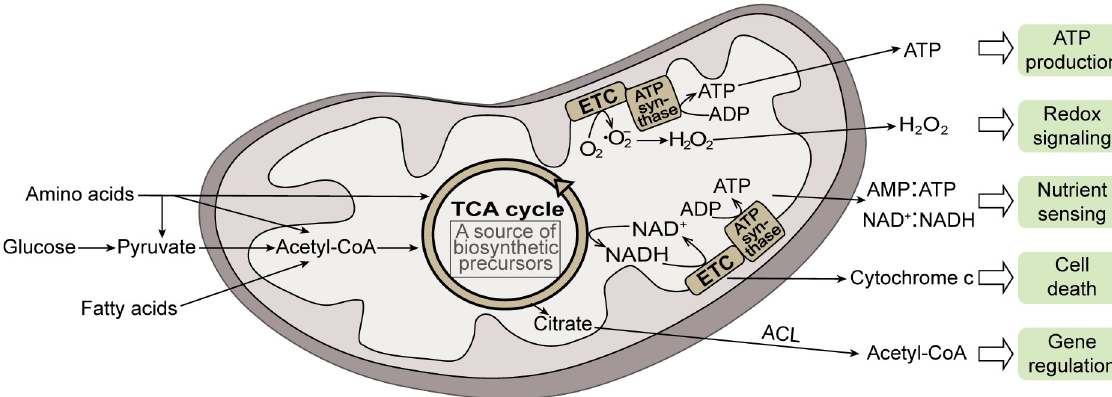
Fig 1. The mitochondrion is a multifunctional organelle. During mitochondrial bioenergetics, acetyl-CoA converted from food molecules is oxidized to produce ATP. In addition to ATP production, mitochondria play essential roles in cell signaling including nutrient sensing, redox signaling, cell death, and many other functions [3, 7]. Note that biosynthetic pathways in mitochondria [4] are omitted in the diagram. ADP, adenosine diphosphate; AMP, adenosine monophosphate; CoA, coenzyme A; ETC, electron transport chain; TCA, tricarboxylic acid.